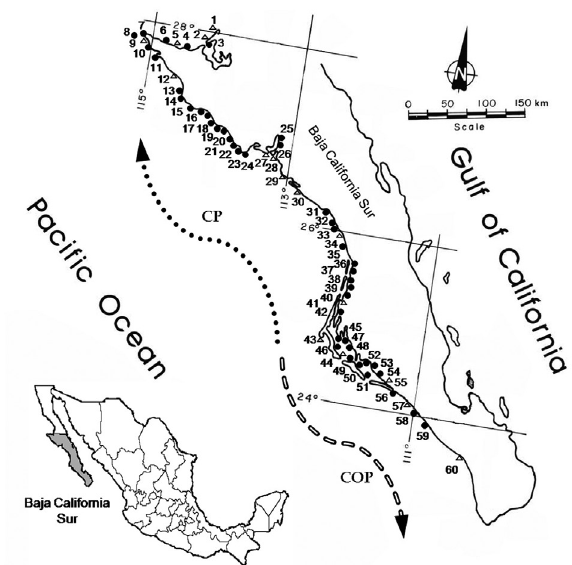
Fig . 1. – Locations of artisanal camps along the Pacific coast of Baja California Sur, Mexico. Open triangles ( r ) indicate sites where biological data were collected. Numbers refer to codes in Table 1. Biogeographical zones: CP, California province; COP, Cortez